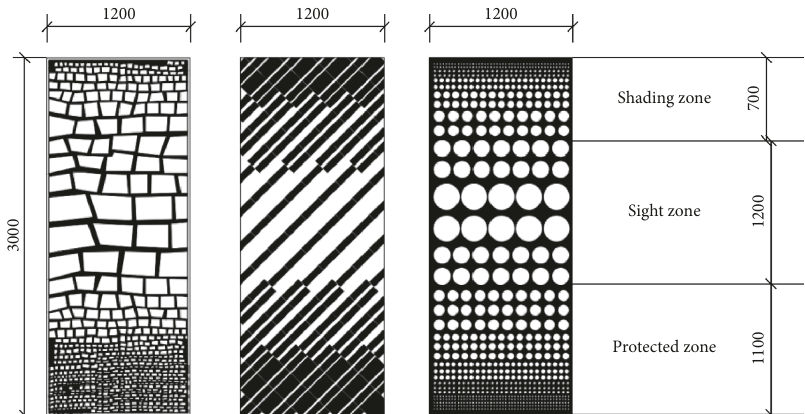
Figure 12: Vertical division of the sample outer layer (source: authors’ own